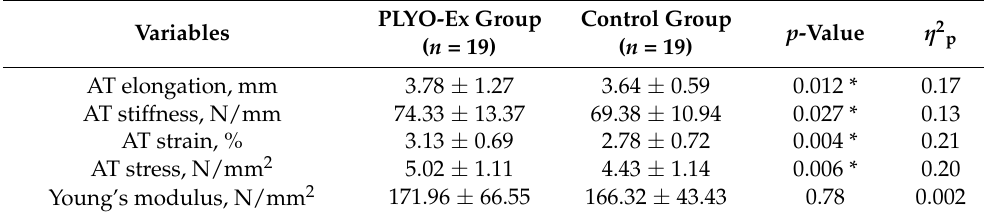
Table 5. Post-treatment differences in ankle muscle-tendon mechanical and material properties (calculated at the common peak torque) between the PLYO-Ex and control group. PLYO-Ex Group Variables ( n =